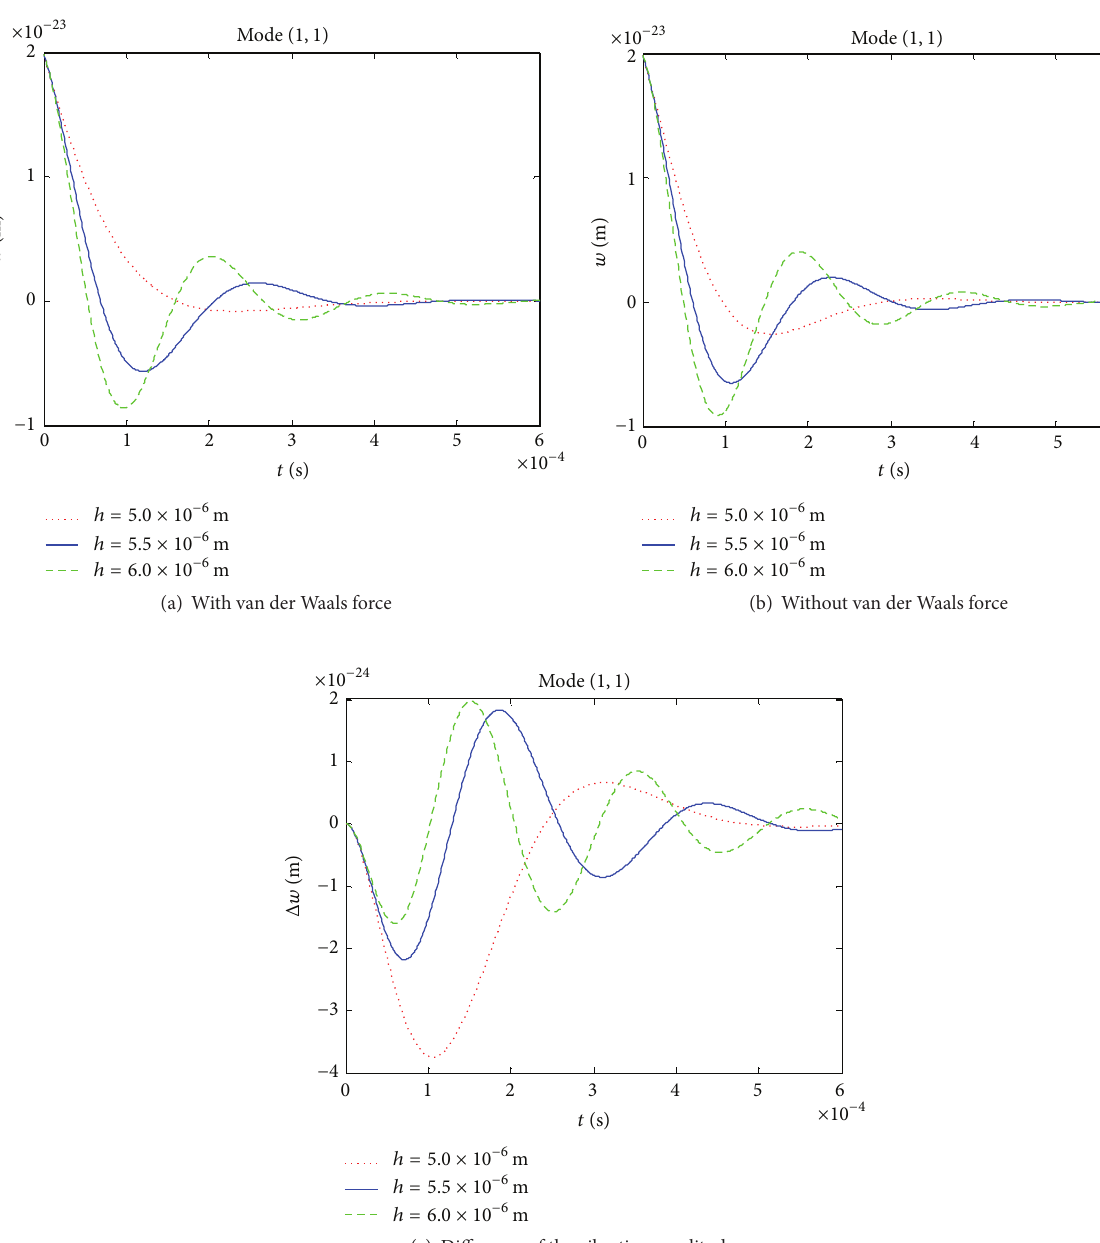
Figure 4: Effects of the van der Waals force on vibrating amplitude of the film center for various ℎ .